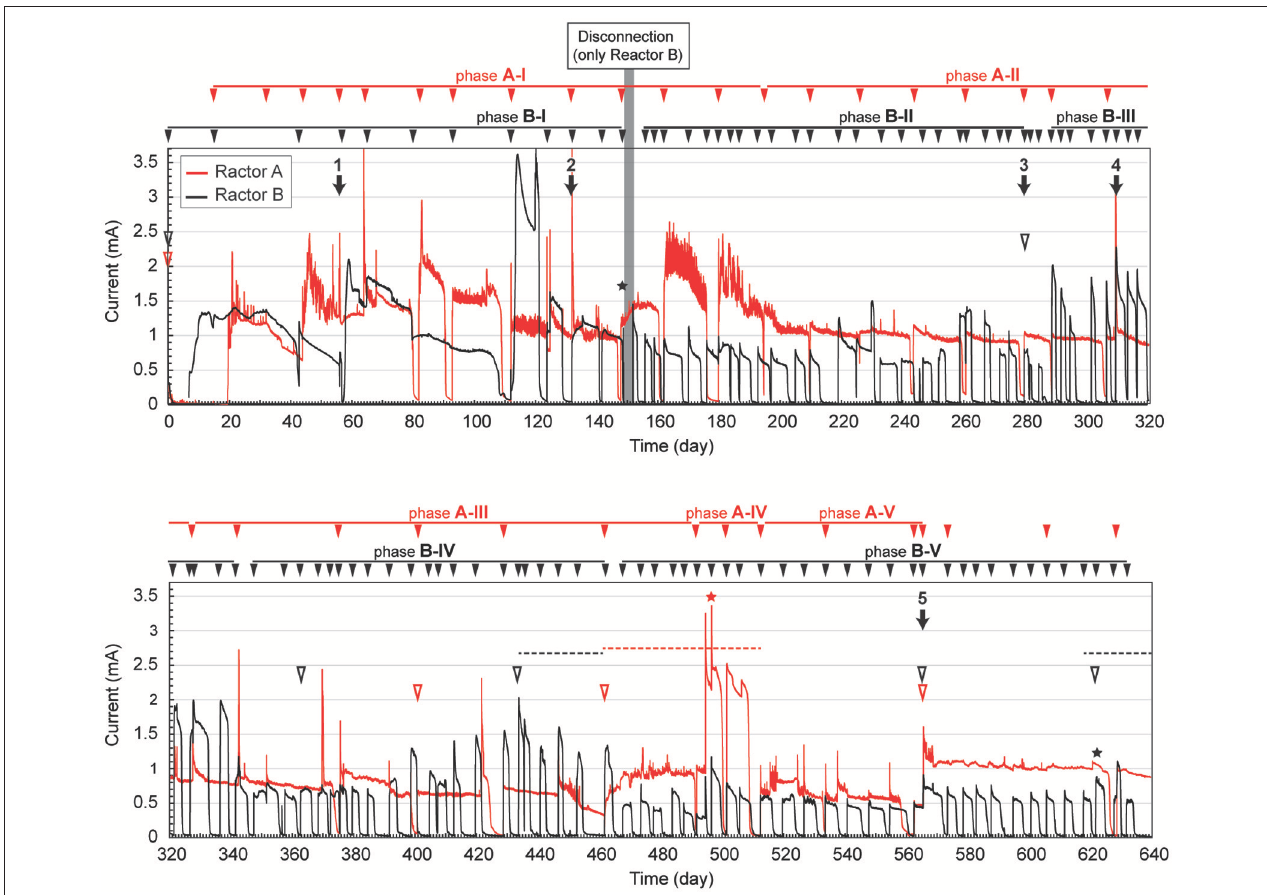
FIGURE 2 | Long-term electrical current output in duplicate BES reactors fed with acetate. Current generation with 600mV of voltage application in duplicate single-chambered BESs is shown as red (reactor A) and black (reactor B) lines. Filled arrowheads above charts indicate feeding of acetate to the BES. Filled arrows indicate biofilm and suspension sampling for DNA extraction, and the numbers above the arrow indicate IDs for the microbial community composition analysis. Open arrowheads indicate exchange of formation water in the BESs. Stars indicate step voltammetry. Dashed lines indicate methane concentration logging. The marks with red color indicate reactor A, while marks with black color indicate reactor